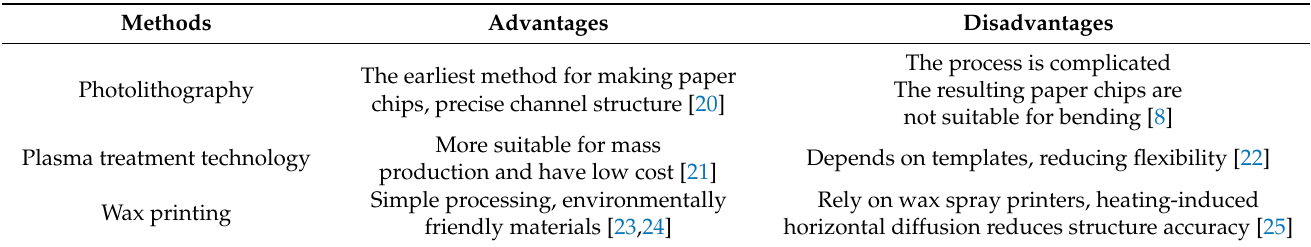
Table 2. Preparation method of paper-based microfluidic